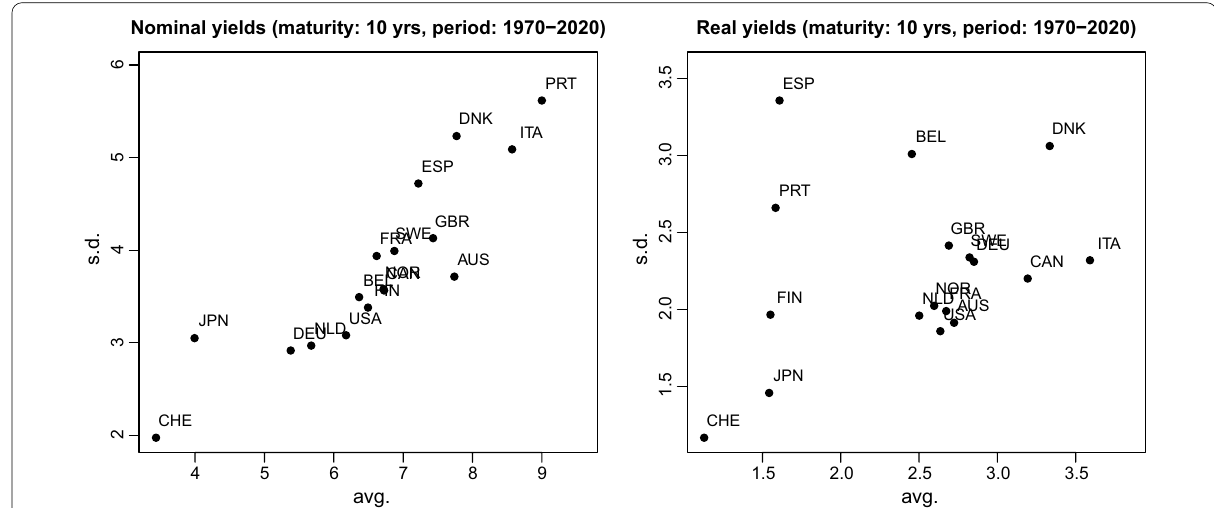
Fig. 2 Means and variances. x‑coordinates correspond to the average interest rates over the period; y‑coordinates give the standard deviation of the interest rates. Yields are expressed in percentage points